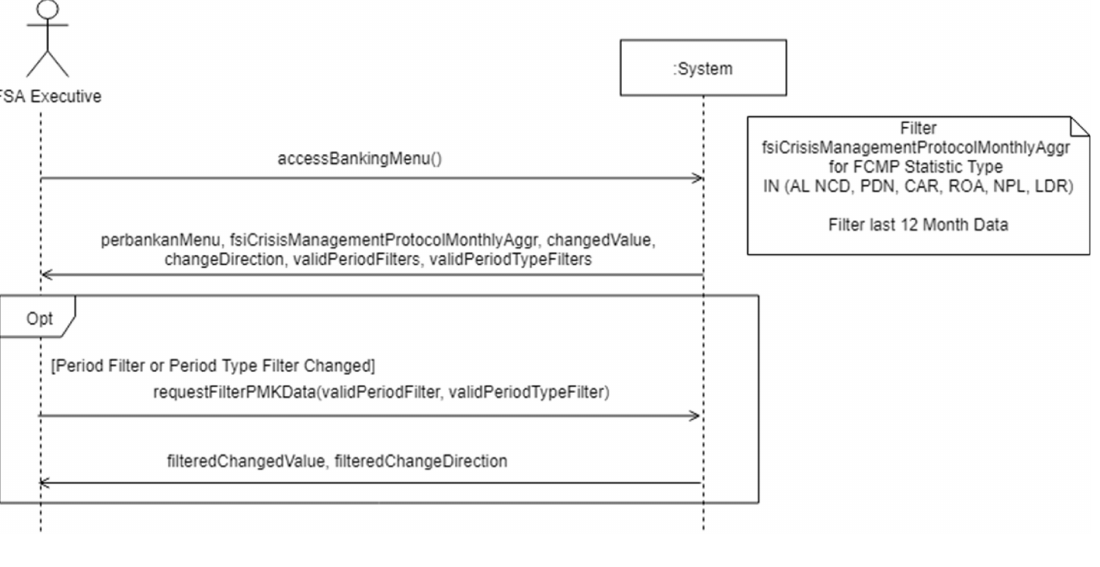
Fig. 4. Fragment of Sequence Diagram